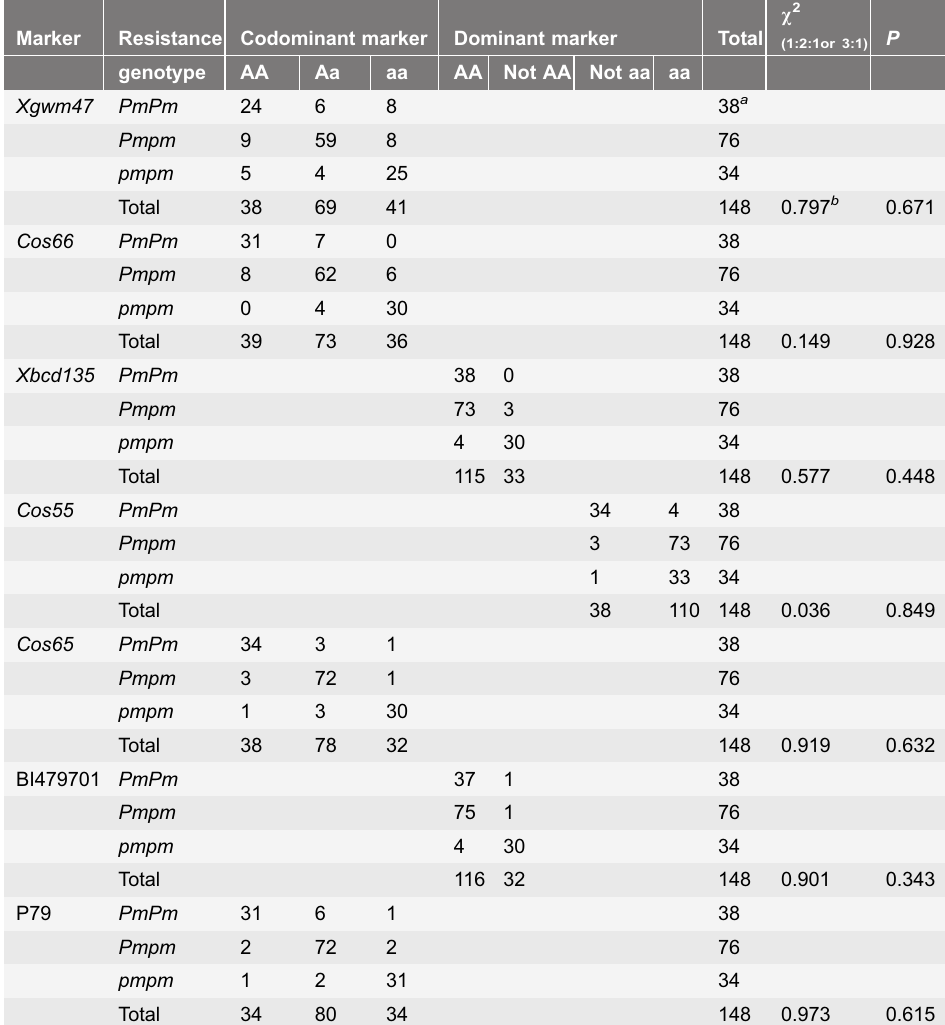
AA homozygous for the CH7086 allele; aa homozygous for the CH5241 allele; Aa heterozygous. a The data of F 2:3 lines from CH5241/CH7086; b Values for significance of x 2 at P 5 0.05 is 3.84 for 1 df and 5.99 for 2 df ,